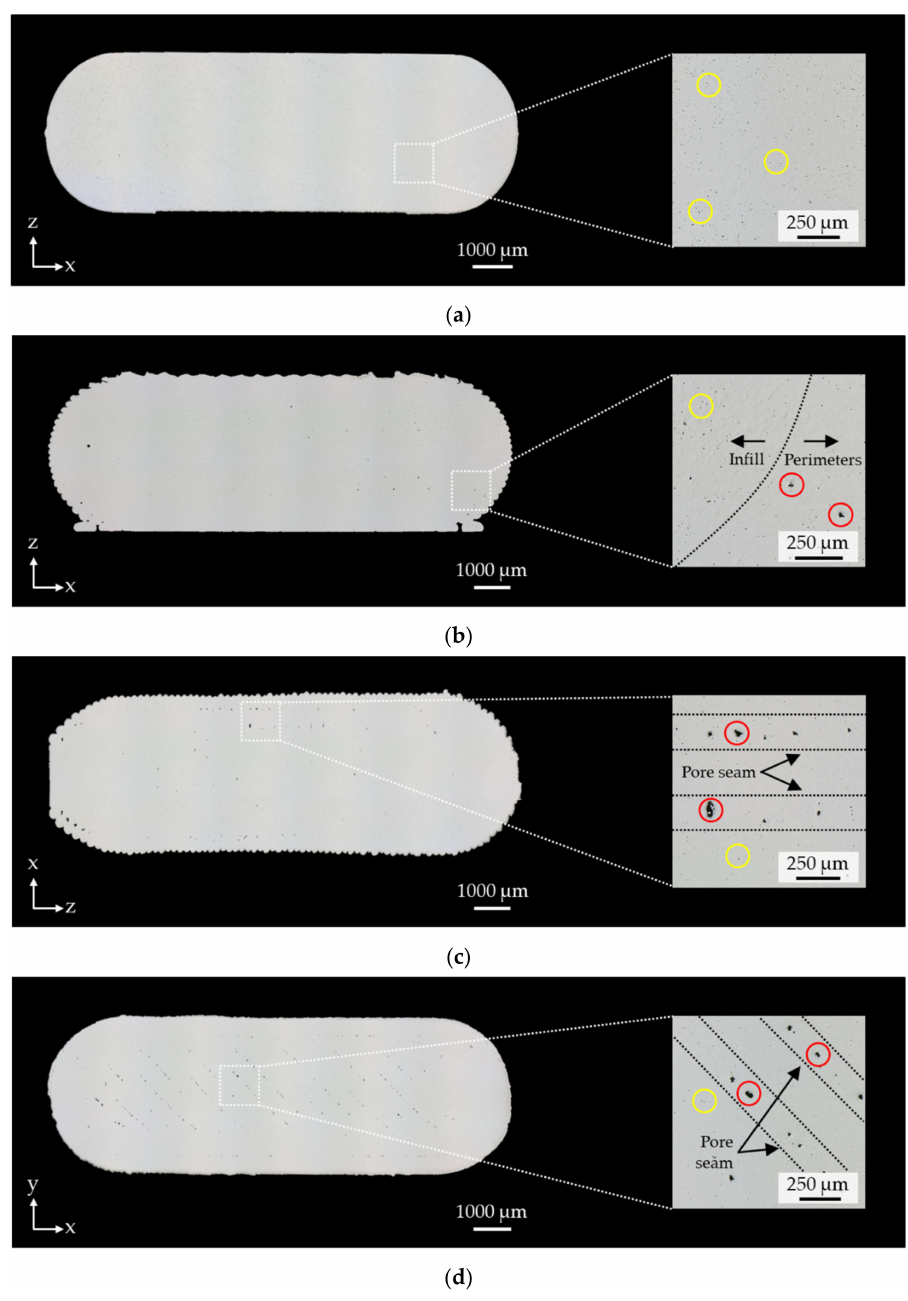
Figure 15. Micrographs of the cut specimen heads from the MIM reference and the investigated build orientations for density analysis; pores due to sintering marked in yellow and pores due to PEX marked in red: ( a ) MIM reference; ( b ) flat orientation; ( c ) side orientation; ( d ) vertical